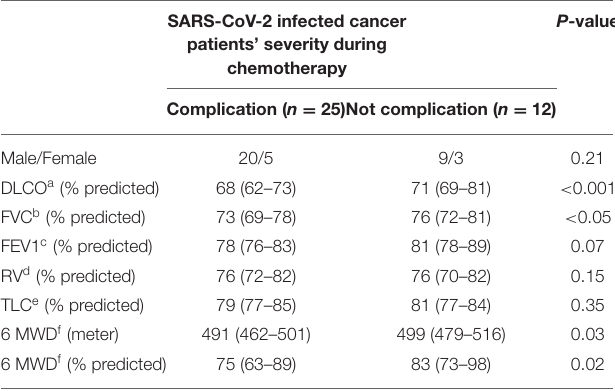
TABLE 3 | The correlation of pulmonary function and complications in patients with cancer who underwent anti-cancer therapy. SARS-CoV-2 infected cancer patients’ severity during